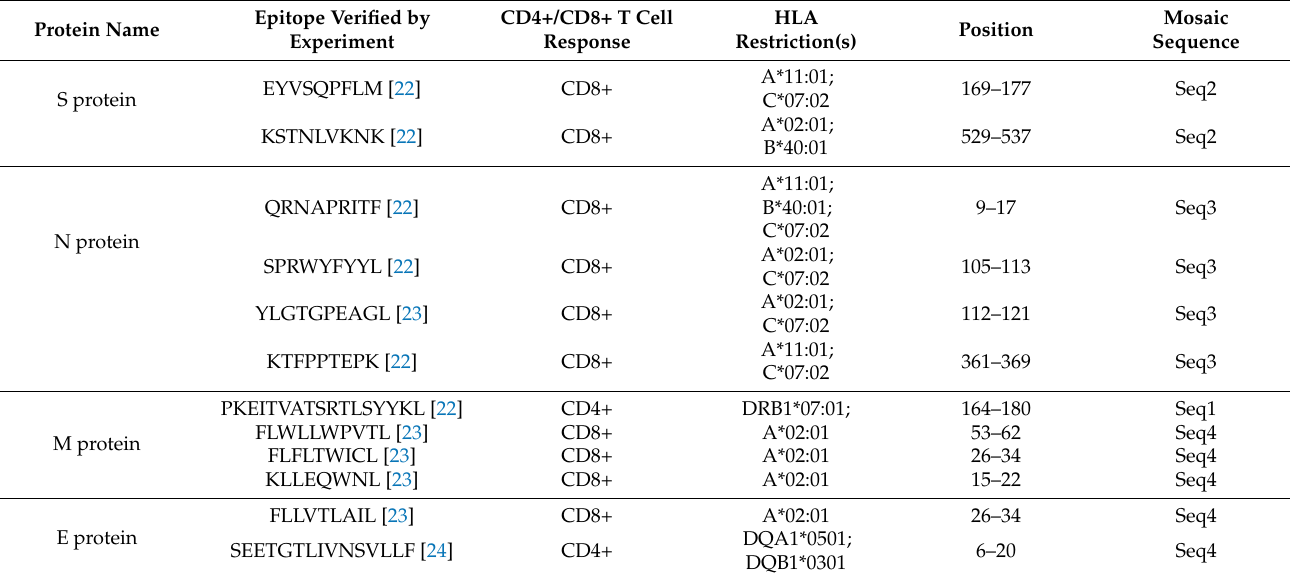
Table 5. The epitope verified by experiment contained in the mosaic